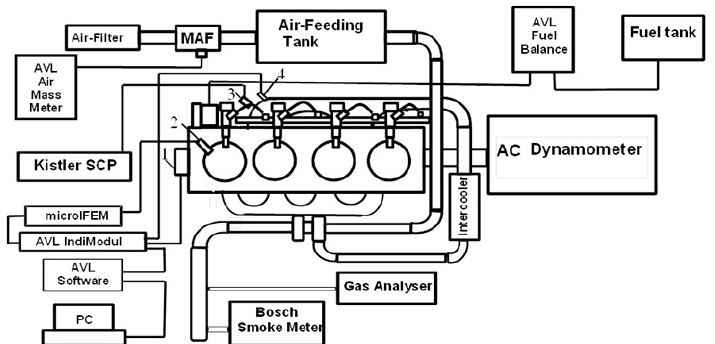
Figure 1. Schematic view of the engine test stand: (1) AVL (Graz, Austria) crank-angle encoder; (2) piezoelectric in-cylinder pressure transducer; (3) fuel high-pressure line transducer attached in front of the injector; and (4) air boost pressure sensor mounted inside the intake manifold. MAF—Mass Air Flow; SCP—Signal Conditioning Platform. Table 1. Specifications of an engine and its fuel system.